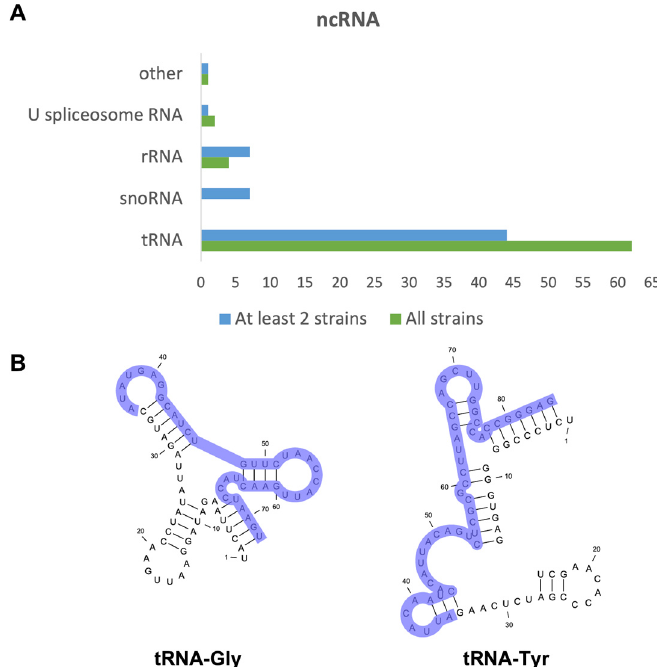
Figure 3. ncRNAs present in C. auris EVs. ( A ) Bar chart describing the most prevalent classes of